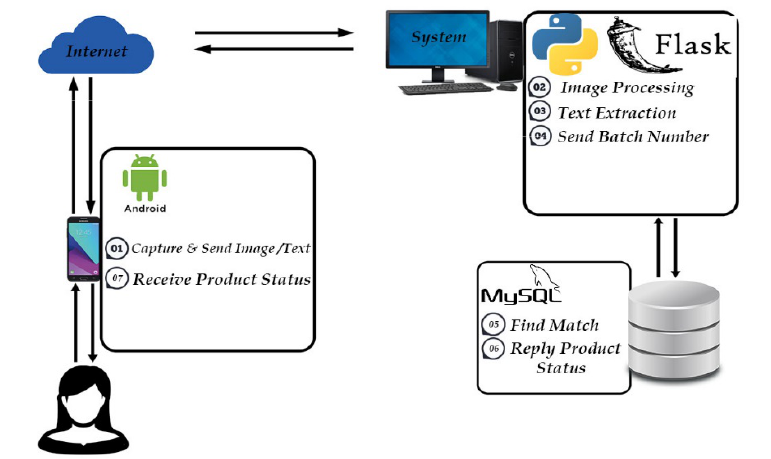
Figure 2. Research Framework